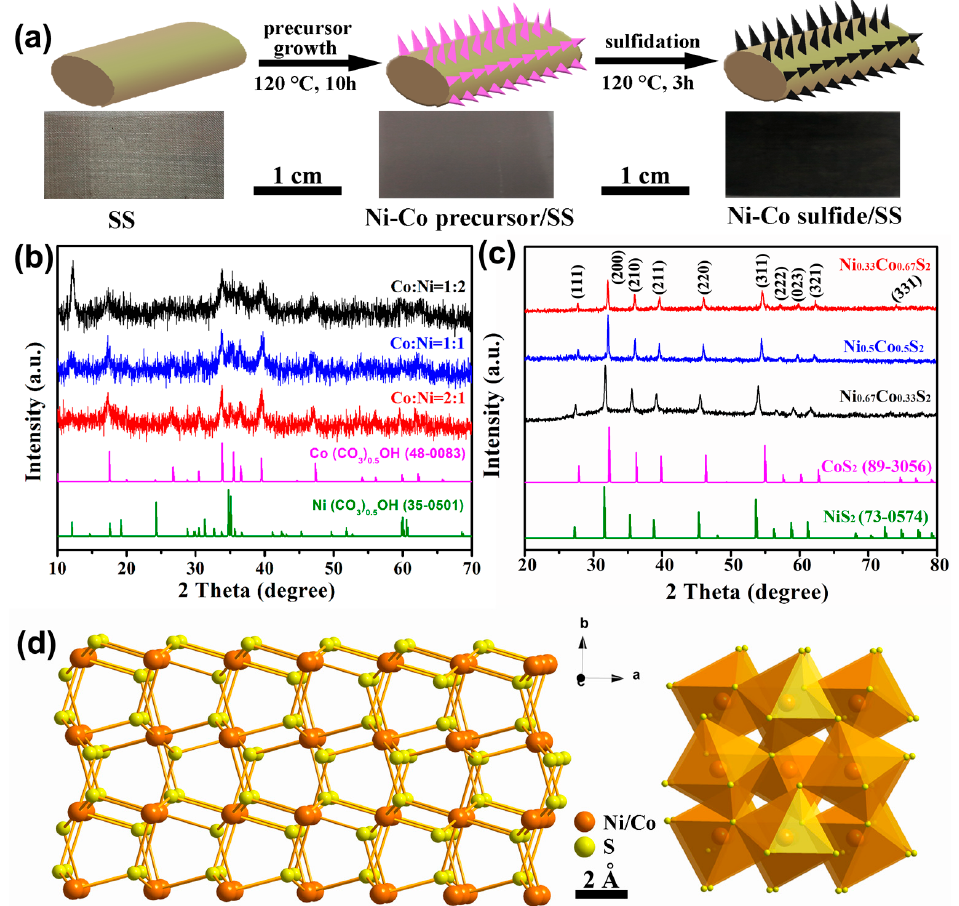
Figure 1. ( a ) Schematic illustration of the preparation procedures of Ni x Co 1 − x S 2 NN/SS and the corresponding electrode photographs; ( b ) XRD patterns of Ni–Co composite precursors and ( c ) final Ni x Co 1 − x S 2 with Ni/Co ratios of 1:2, 1:1, and 2:1, respectively. The standard peaks of CoS 2 and NiS 2 are also shown for comparison; ( d ) Crystal structures of pyrite ‐ type Ni x Co 1 − x S 2 .